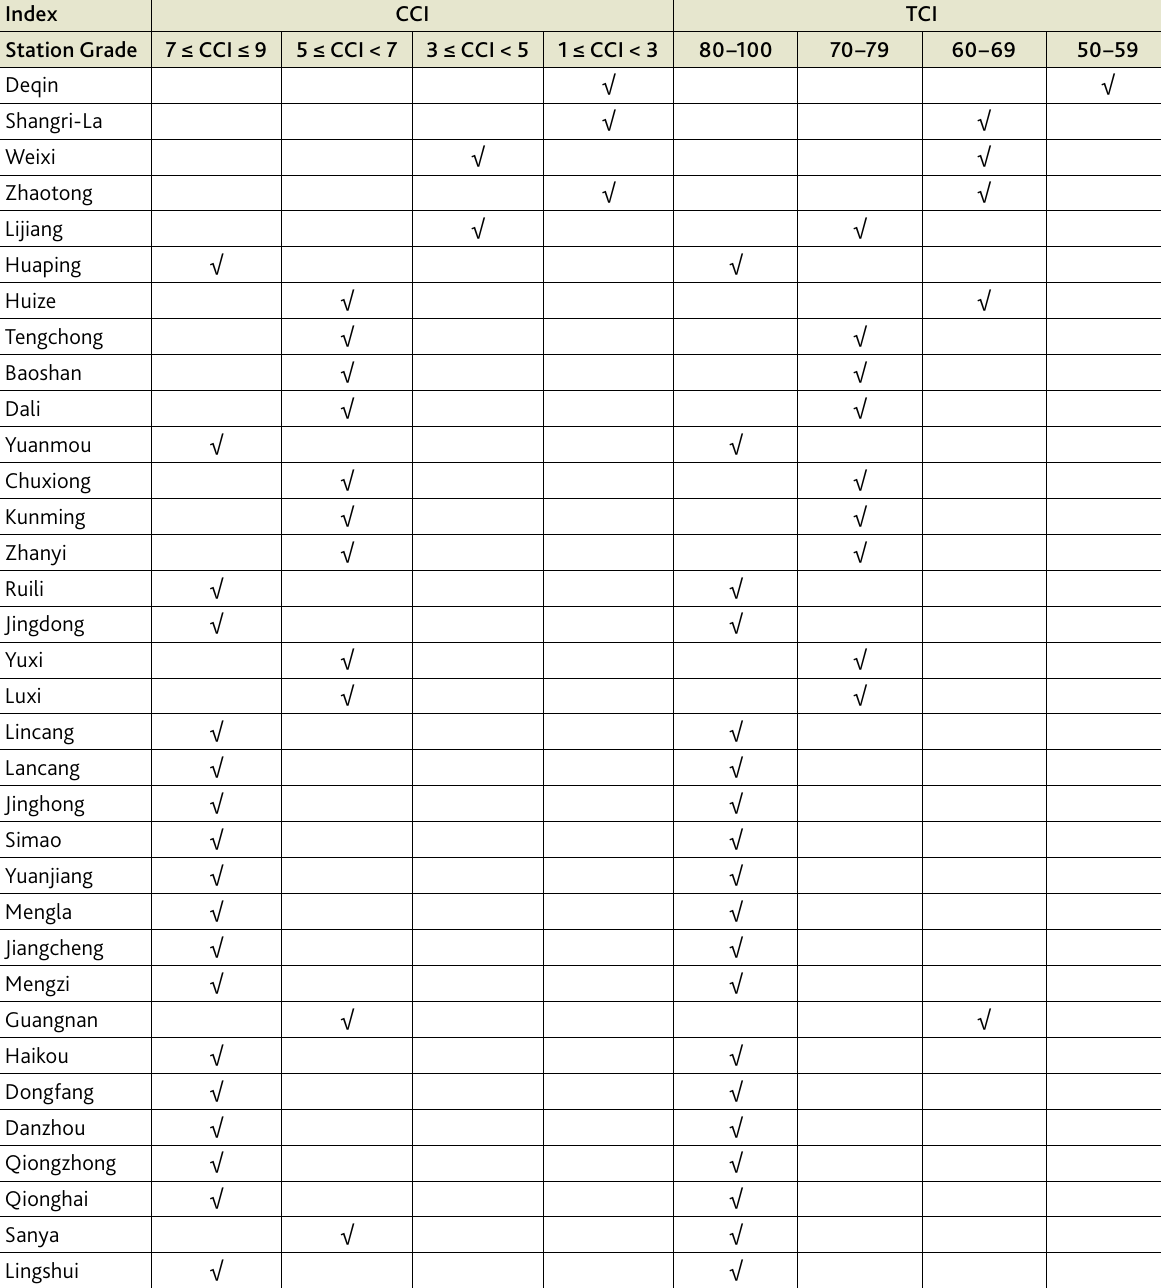
Table 5. February CCI and TCI classifications for Yunnan (first 27 stations) and Hainan (last 7 stations) provinces between 1981 and